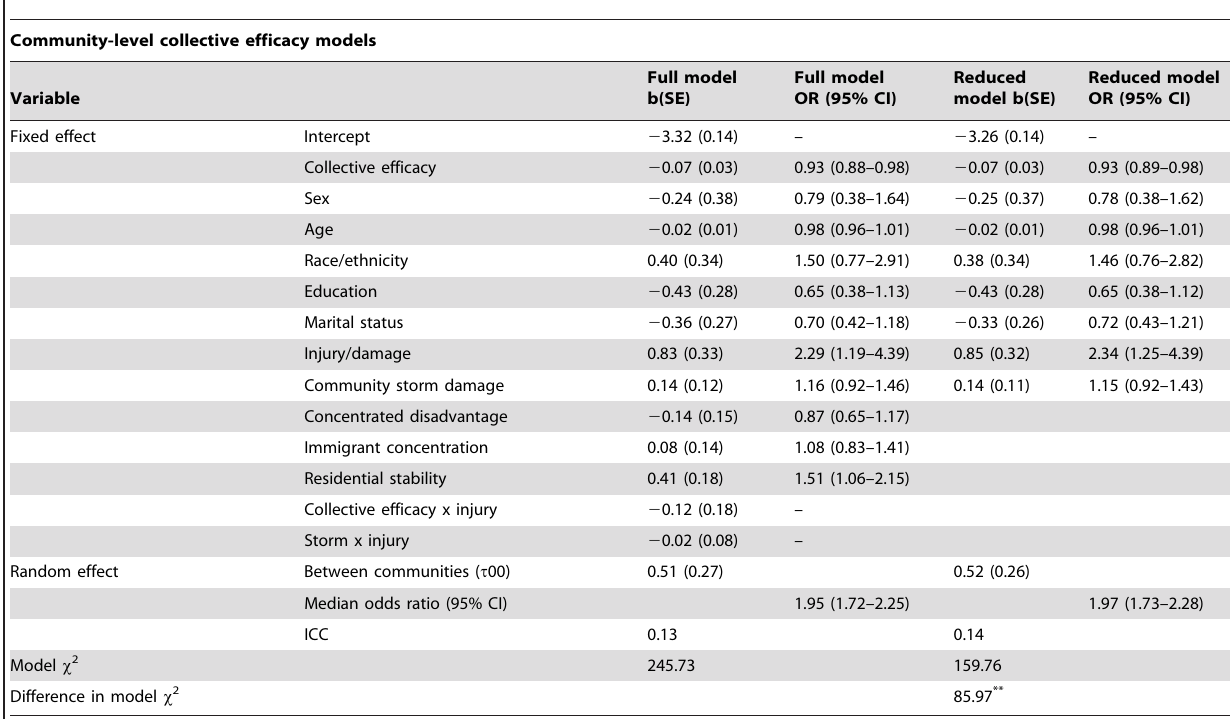
Table 6. Parameter estimates of multilevel logistic regression models for community-level collective efficacy on probable PTSD